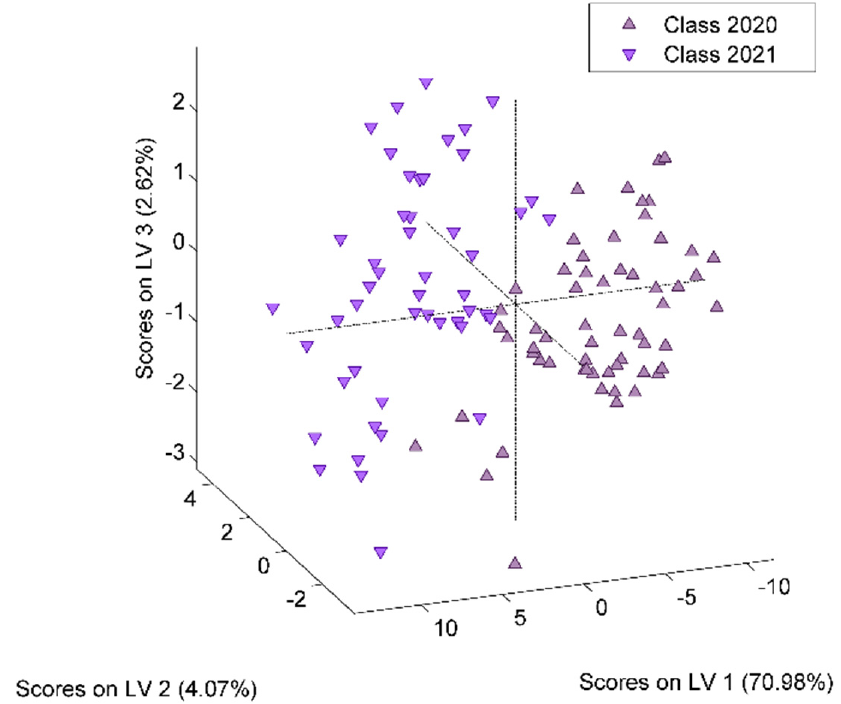
Figure 4. Score plot corresponding to the developed PLS-DA model for the harvesting year differ- entiation of the honey samples.